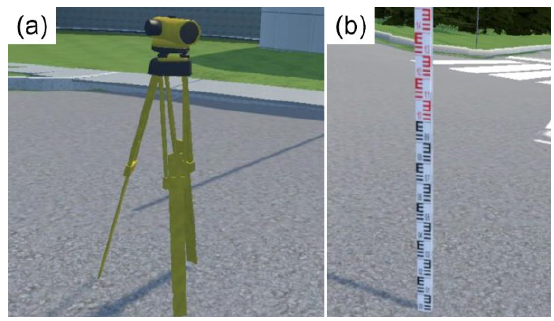
Figure 4. Virtual reality models (a) tripod and level (b) rod